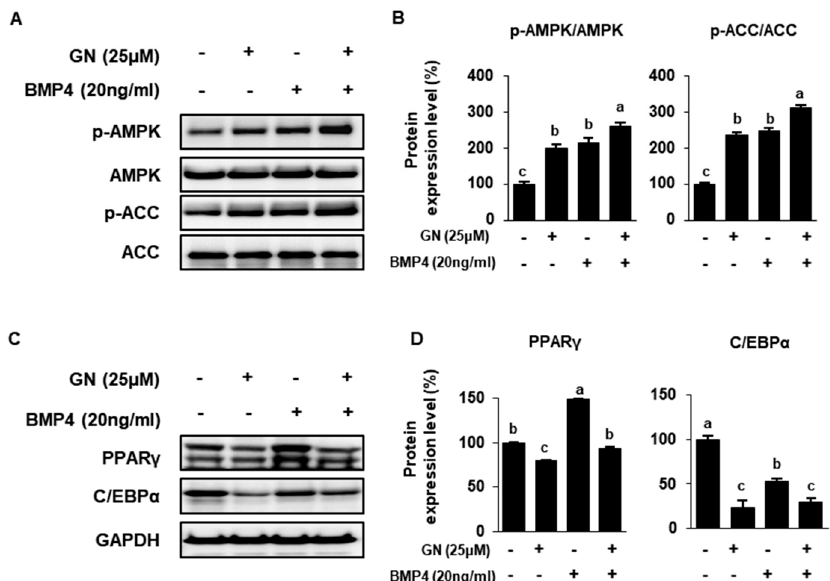
Figure6. Additivee ff ectsofBMP4andGNonAMPKactivationandadipogenesisin3T3-L1cells. 3T3-L1 Figure 6. Additive effects of BMP4 and GN on AMPK activation and adipogenesis in 3T3-L1 cells. cells were treated with 20 ng / mL BMP4 ± 25 µ M GN, h-and e ff ects on protein phosphorylation and / or 3T3-L1 cells were treated with 20 ng/mL BMP4 ± 25 μ M GN, h-and effects on protein expression were determined. ( A , B ) Western blotting for p-AMPK, AMPK, phosephorylated acetyl-CoA phosphorylation and/or expression were determined. ( A , B ) Western blotting for p-AMPK, AMPK, carboxylase (p-ACC) and ACC in 3T3-L1 cells and quantification of band density. ( C , D ) Western phosephorylated acetyl-CoA carboxylase (p-ACC) and ACC in 3T3-L1 cells and quantification of blotting for the adipogenic proteins PPAR γ and C / EBP α in 3T3-L1 cells and band density quantification. band density. ( C , D ) Western blotting for the adipogenic proteins PPAR γ and C/EBP α in 3T3-L1 cells Protein data are expressed as mean ± SD ( n = 4). Values with di ff erent letters are significantly di ff erent, and band density quantification. Protein data are expressed as mean ± SD ( n = 4). Values with p < 0.05 (a > b > c > d). BMP4; Bone morphogenetic protein different letters are significantly different, p < 0.05 (a > b > c > d). BMP4; Bone morphogenetic protein 4.